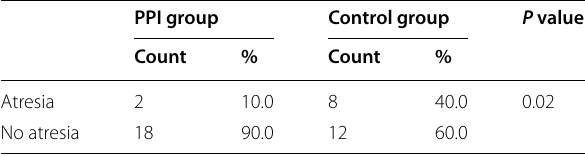
Table 1 Percentage of choanal restenosis among the two groups